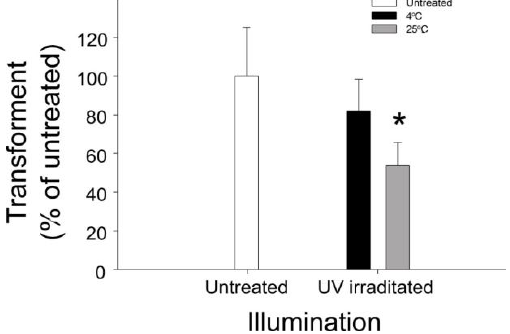
Figure 1. Influence of heat on photocatalyst-induced DNA damage. Plasmid pBlueScript II SK + DNA was transformed to Escherichia coli ( E. coli ) competent cells after photocatalysis environments set to 4 ◦ C and 25 ◦ C. The level of DNA damage involving ultraviolet (UV)- and heat-induced nanoscale-TiO 2 film-mediated photocatalysis was indicated by the reduction of transformants. * p < 0.05 vs. 4 ◦ C group. n = 6, three experiments with two